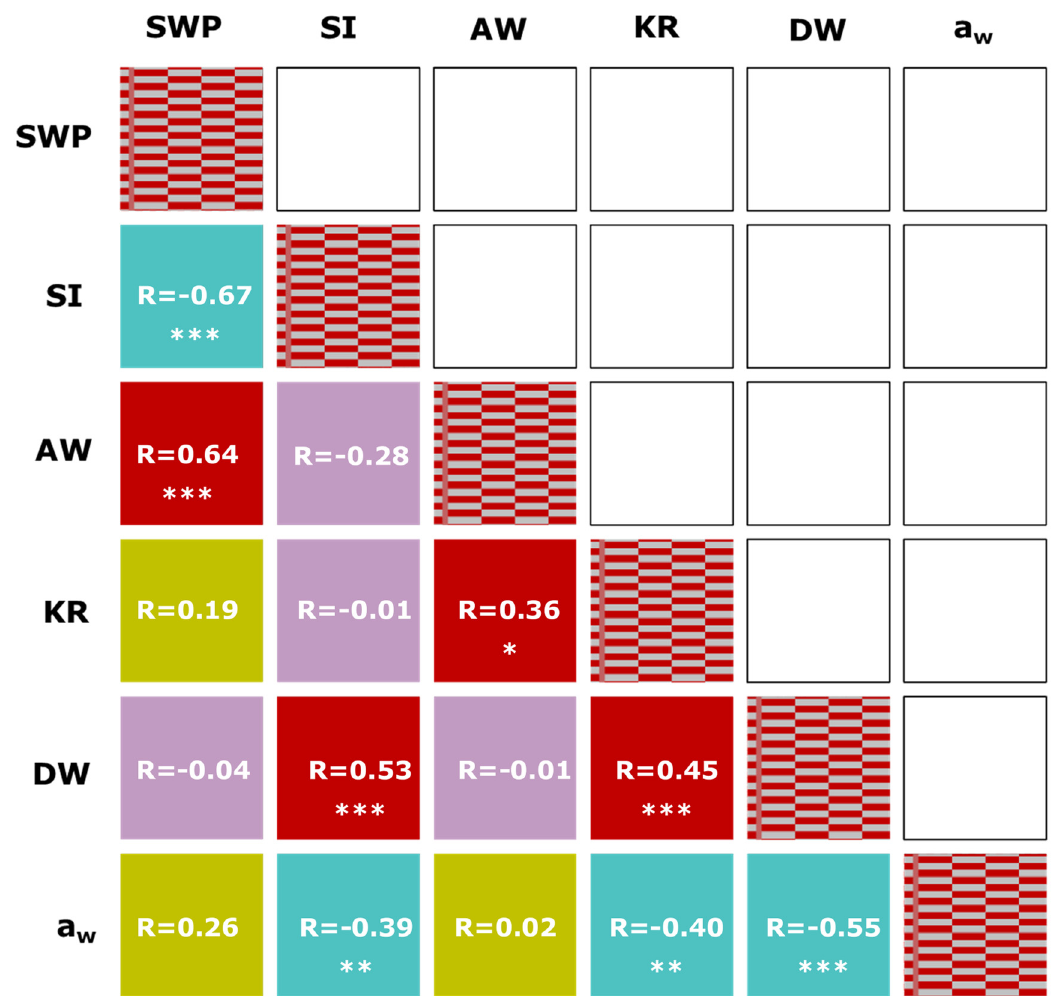
Figure 2. Heat map of correlation matrix of agronomical parameters. Each square indicates Pearson’s correlation coe ffi cient for a pair of data and the color represents the positive or negative correlation as: